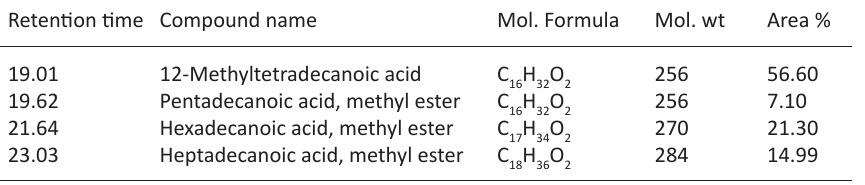
Table 5. GC-MS analysis of Fatty acid methyl esters in cell wall of isolate SKCMM1 Retention time Compound